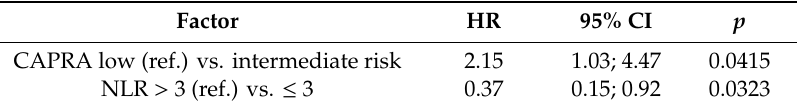
Table 2. Multivariate analysis predicting biochemical